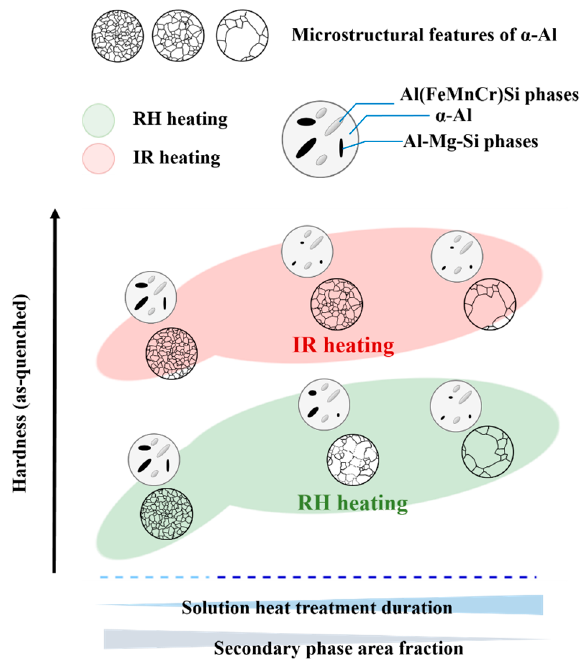
Figure 15. Evolution of microstructure and hardness during rapid heating process.